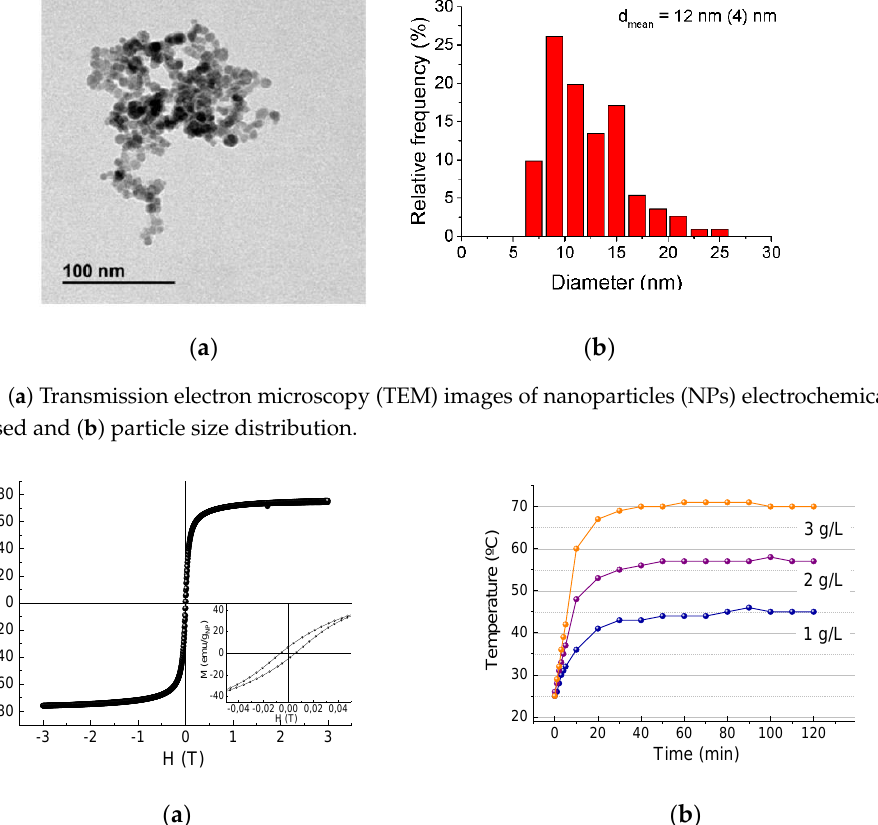
Figure 2. (a) Hysteresis loop of the sorbent at room temperature, inset is the zoom of the central area. ( b ) Temperature versus time plots at 1, 2, and 3 g/L nanoparticle concentration under the effect of a magnetic field (f = 222 kHz, I = 350 A).